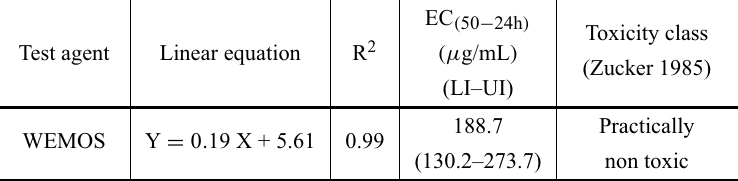
Linear regression analysis of immobility tests performed on Daphnia magna ) value with lower (LI) and upper (UI) 95% organisms and the EC ( 50 − 24 h confidence intervals calculated for the water extract of Moringa oleifera seeds (WEMOS).